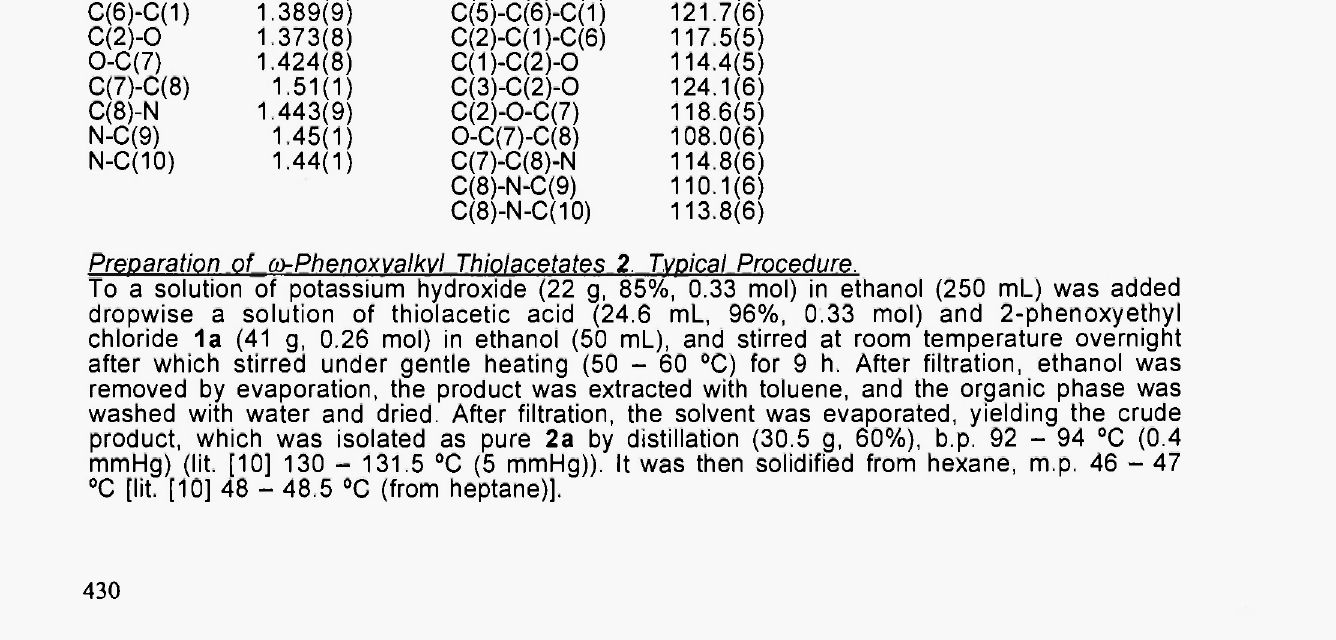
Figure 1. Table III. Bond Lengths ( A ), Angles (cleg), and Selected Torsion Angles (deg) of